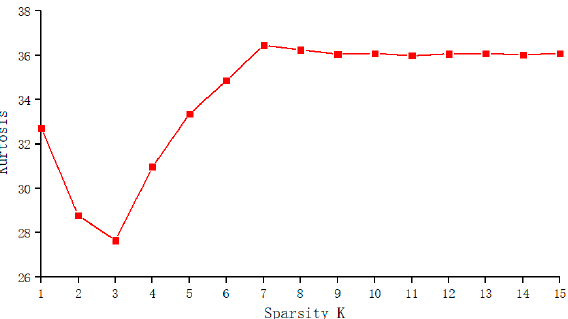
Figure 6. Relationship between sparsity and reconstructed signal envelope spectral kurtosis. Table 2. The parameters of the constructed